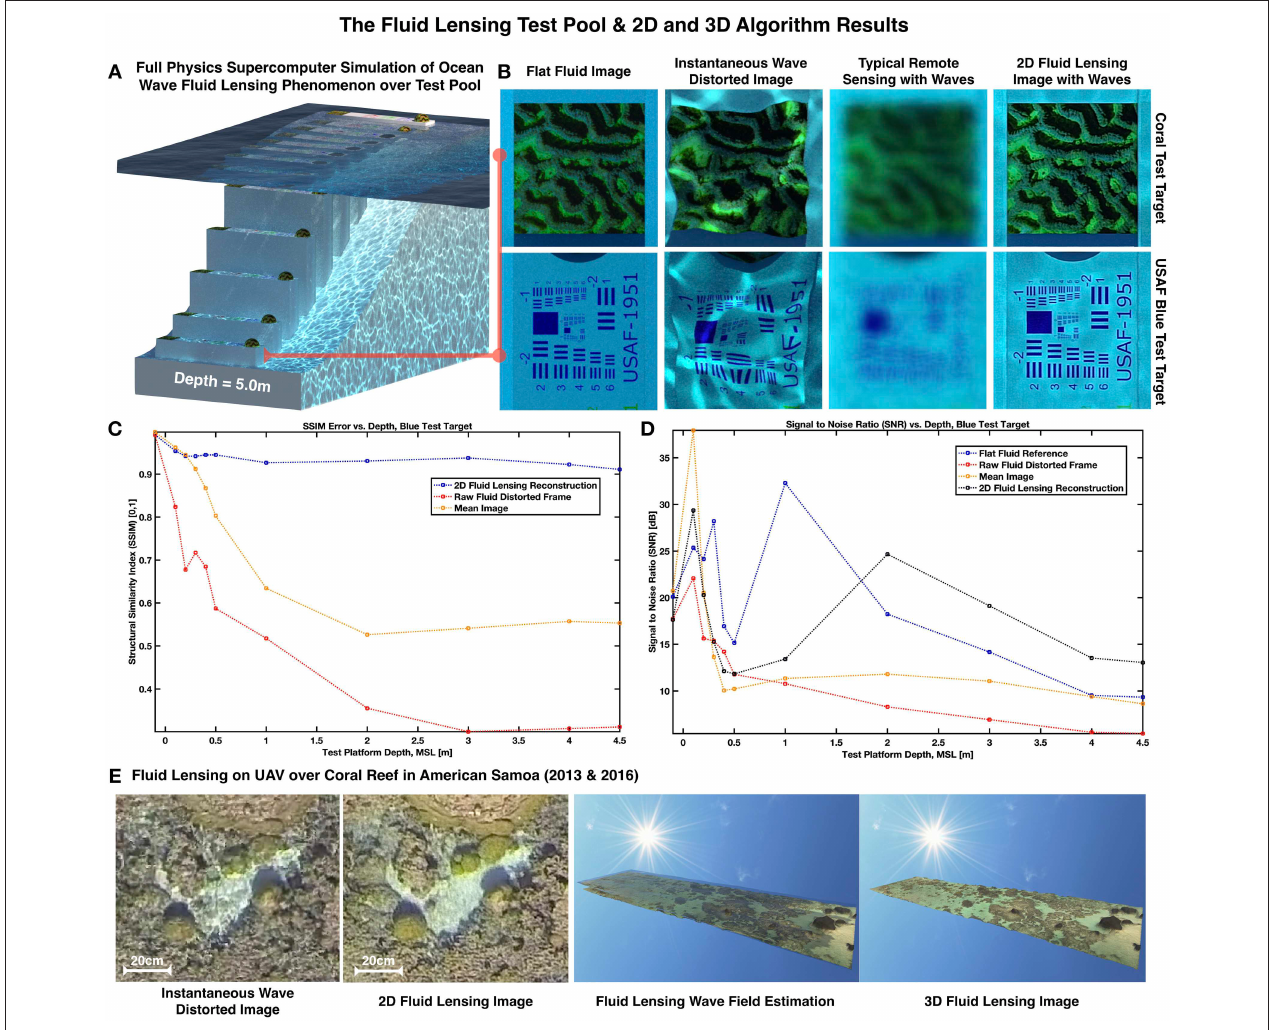
FIGURE 3 | The Fluid Lensing Test Pool, 2D, and 3D Fluid Lensing Algorithm results. (A) A side render of the Fluid Lensing Test Pool showing formation of caustics on floor and optical attenuation (water volume removed for clarity). (B) 2D Fluid Lensing Algorithm Results as compared to a flat fluid state, instantaneous image, and image with integration time. (C,D) Structural Similarity Index (SSIM) and signal-to-noise ratio (SNR) for fluid lensing results as a function of depth. (E) 2D and 3D Fluid Lensing Algorithm results from 2013 and 2016 airborne campaigns in American Samoa. Adapted with permission from Chirayath (2016).